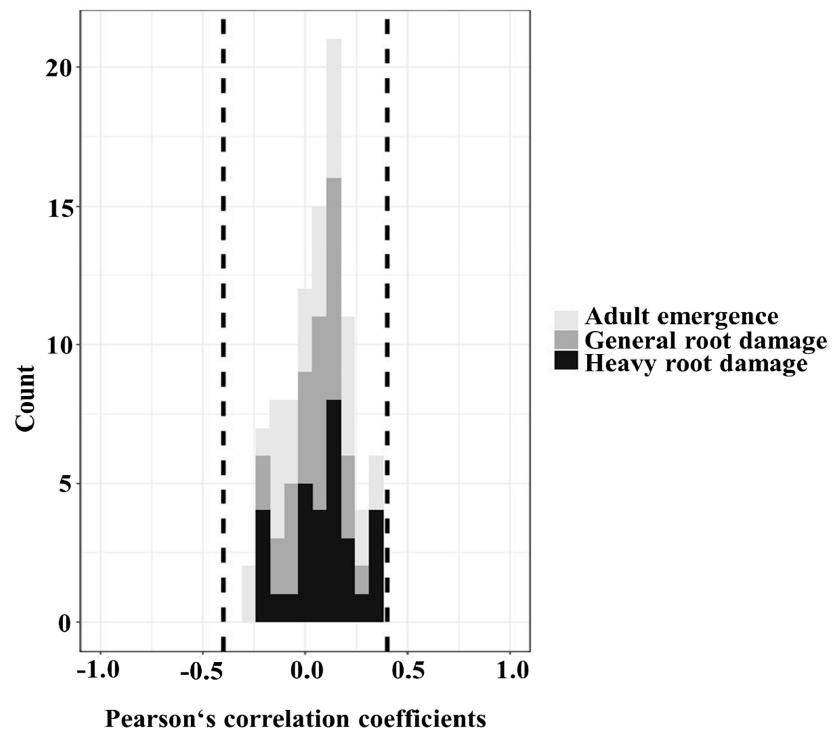
Figure 2. Histogram of the distribution of Pearson’s correlation coefficients between the 32 investi- gated abiotic and biotic factors and the efficacies of the entomopathogenic nematode Heterorhabditis bacteriophora in reducing Diabrotica v. virgifera population and protecting against heavy and general root damage in maize at 20 sites across 10 years in southern Hungary. Dashed lines represent the border of − 0.4 and 0.4 for the r coefficient values that were set to be the threshold for factor selection for regression modeling.